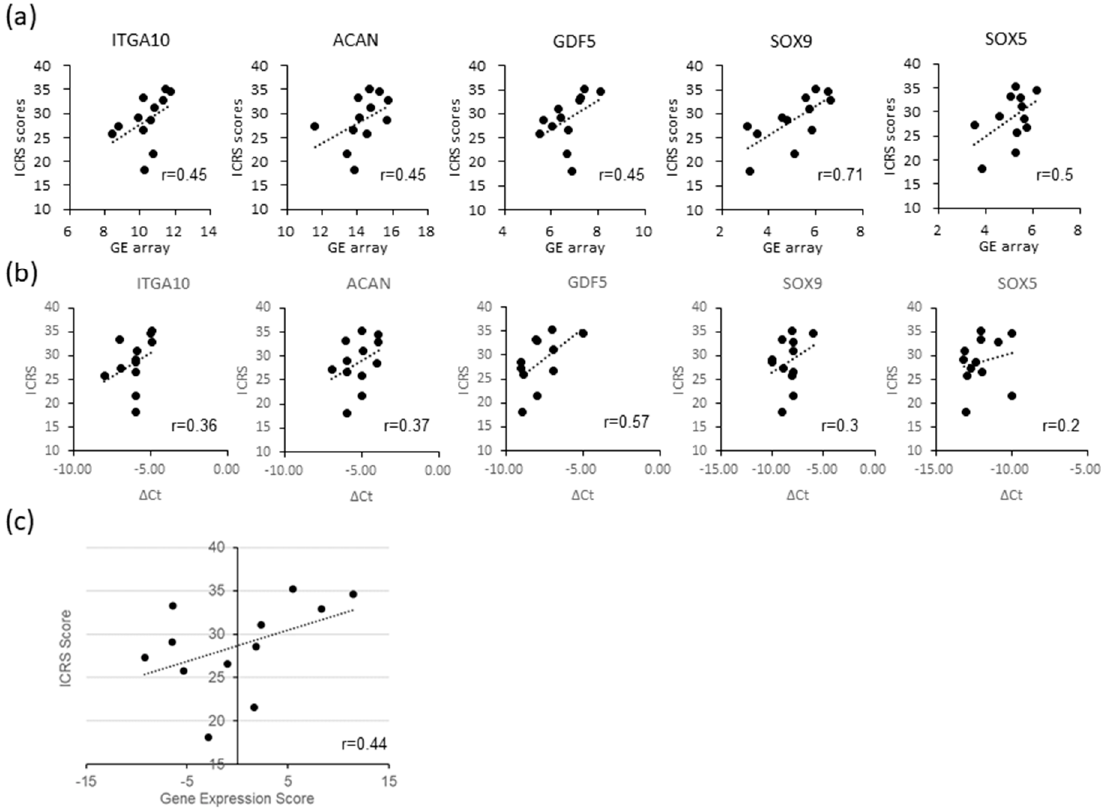
Figure 4. Potential e ffi cacy-related markers for PD sheets: ( a )The scatterplots of selected genes show a correlation between normalized microarray signal and ICRS scores of PD sheets ( n = 12). ( b ) A weak correlation between gene expression in PD sheets that is consistent with ( a ) and their ICRS scores were validated by RT-PCR. The horizontal axis shows the gene expression level in terms of ∆ Ct values that were calculated by subtracting the Ct value of target genes from the Ct value of actin beta (ACTB) as a reference gene. ( c ) Scatterplot of gene expression score (GES) calculated from gene expression levels of marker genes.